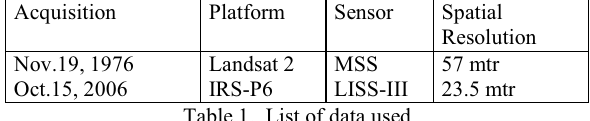
Table 1. List of data used